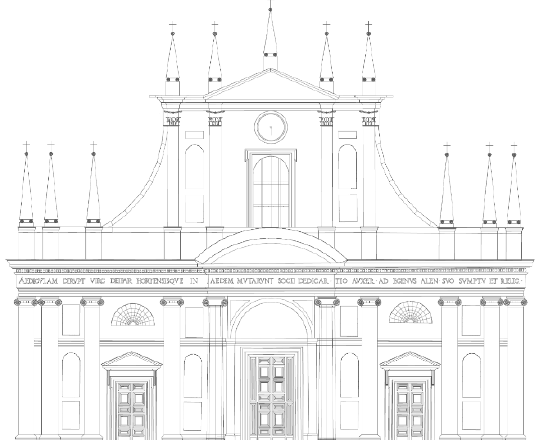
Figure 17 – S. Maria dell’Orto – the plot of the frontal view (plot by G.